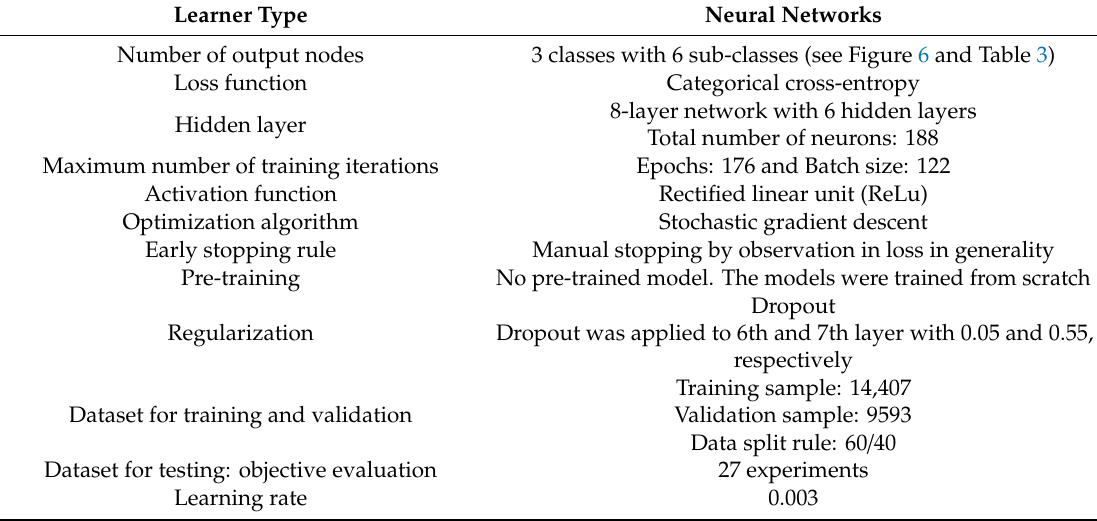
Table 5. Experimental setting of the proposed DNN-based TIG Welding